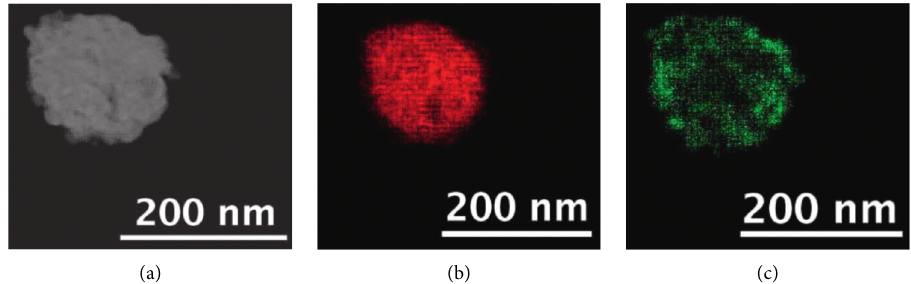
Figure 3: HADDF-STEM images and bimetallic element distraction mapping images of Ag (c)